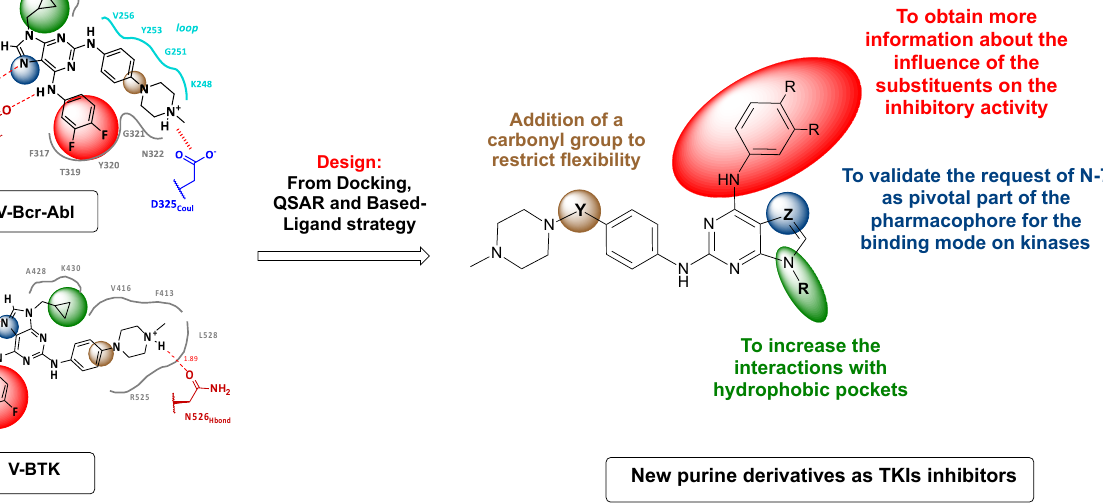
Figure 3. Design of new TKIs based on 2,6,9-trisubstituted purines considering chemical structures of compounds AP-23464 and I – V and docking results of V with Bcr-Abl/BTK.